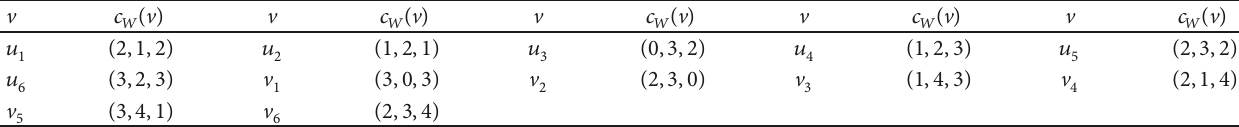
Table 11: The code 𝑐 𝑊 ( V ) of V with respect to 𝑊 = {𝑢 3 , V 1 , V 2 } in 𝑃(6,3) .